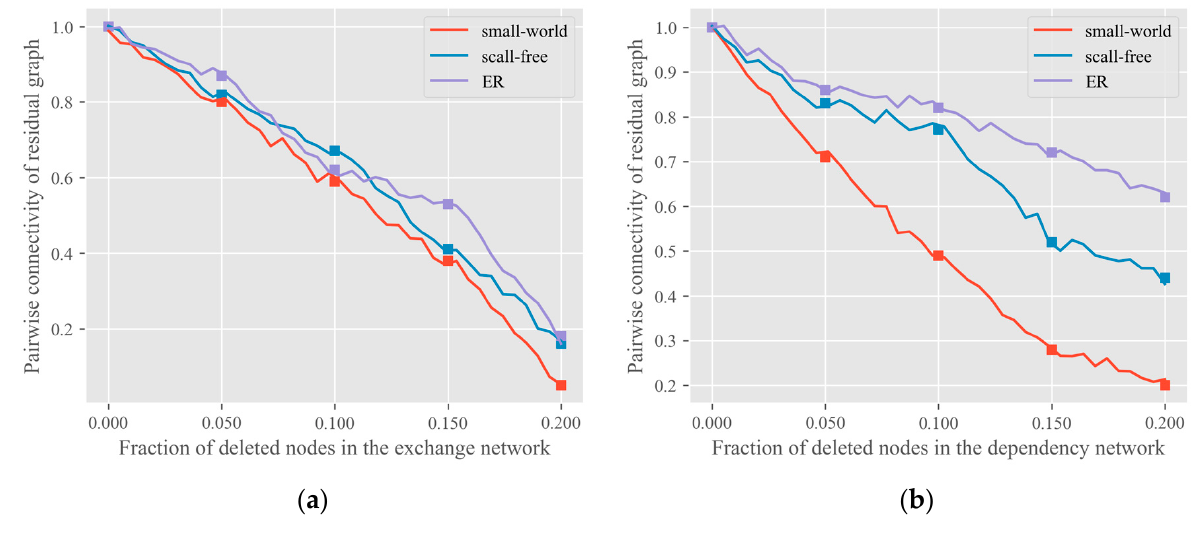
Figure 4. Performance of DMGCN on ( a ) the exchange network and ( b ) the dependency network, with different small-world, scale-free, and ER evolving models.